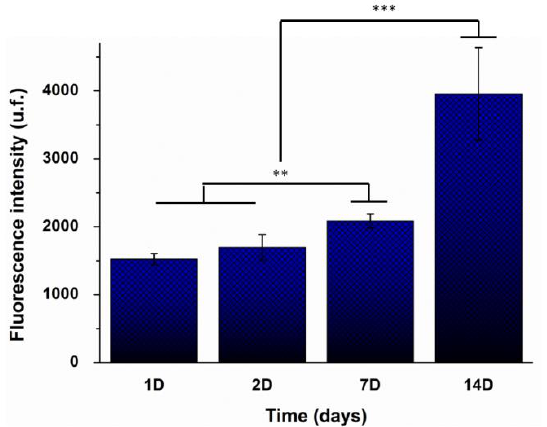
Figure 7. Cell viability of hACs and hOBs co-cultured on the biomimetic scaffolds after 1, 2, 7, and 14 days of incubation. Values represent mean ± SD (n = 5). ANOVA of the results was performed comparing time points each other at significance levels of ** p < 0.005, and *** p < 0.001.